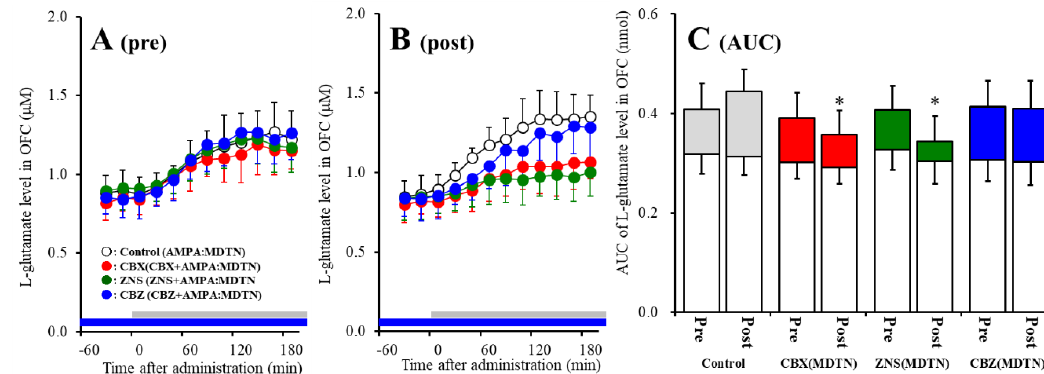
Figure 2. E ff ects of local administration of 100 µ M carbenoxolone (CBX: non-selective hemichannel inhibitor: red circles) and therapeutic-relevant concentration of 100 µ M carbamazepine (CBZ: blue circles, estimated concentration in brain tissue is 22 µ M) and 500 µ M zonisamide (ZNS: green circles, estimated concentration brain tissue is 98 µ M) into the mediodorsal thalamic nucleus (MDTN) on pre amino-3-(3-hydroxy-5-methyl-isoxazol-4-yl)propanoic acid (AMPA)-evoked (panel A : pre) and post-AMPA-evoked (panel B : post) l -glutamate release (before and after hemichannel activation induced by perfusion with Ca 2 + -free with 100 mM K + containing modified Ringer’s solution (FCHK-MRS) into the MDTN for 20 min) in the orbitofrontal cortex (OFC) of wild-type. Ordinates indicate mean extracellular l -glutamate level ( µ M) ( n = 6), and abscissas indicate time after AMPA-evoked stimulations (min). Blue bars indicate the perfusion with CBX, CBZ, or ZNS into the MDTN. Gray bars indicate the perfusion with 100 µ M AMPA into the MDTN (AMPA-evoked stimulation). (Panel C ) indicates the area under curve (AUC) value of extracellular l -glutamate level (nmol) before (basal extracellular l -glutamate level) and after AMPA-evoked stimulation (from 20 to 180 min) of panels A and B. Opened columns indicate the AUC values of basal extracellular levels of l -glutamate in panel A and B. * p < 0.05; relative to control by multivariate ANOVA (MANOVA) with Tukey’s post hoc test.